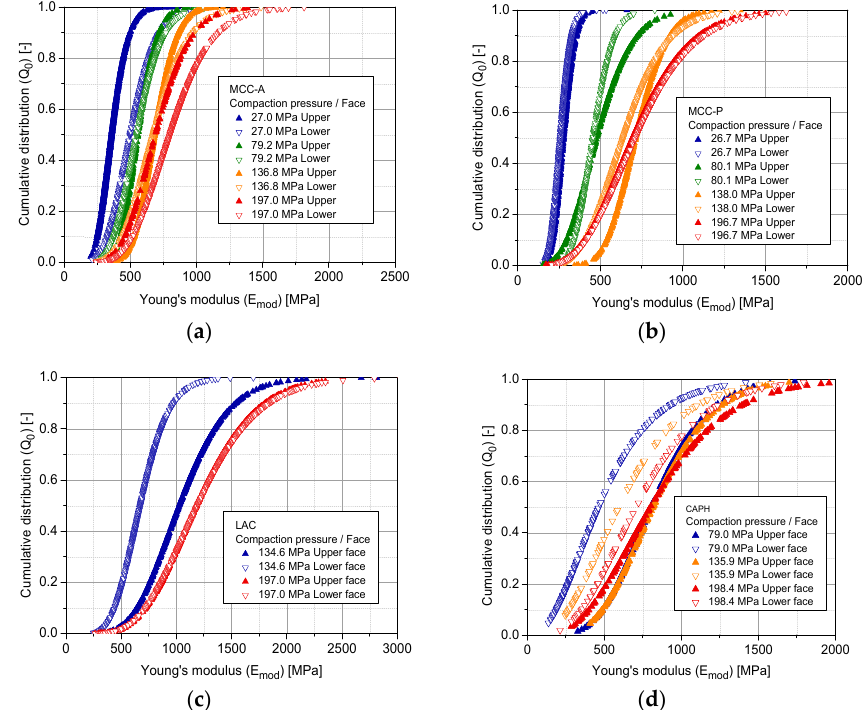
Table 2. Fitting volumetric/weight cumulative parameters for gamma distributions ( (cid:1843) (cid:2868) ) as a function of the maximum compaction pressure for the upper and lower tablet faces. Material Compaction Pressure (MPa) Face Gamma (cid:2193) Factor (-) Gamma (cid:2242) Factor (-)